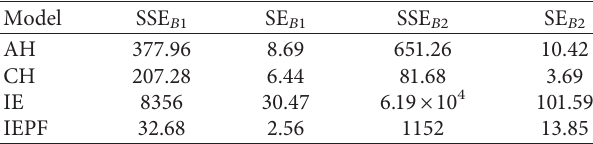
Figure 6: Comparison of each model with the test data from B Table 8: Accuracy of each model for example 2.